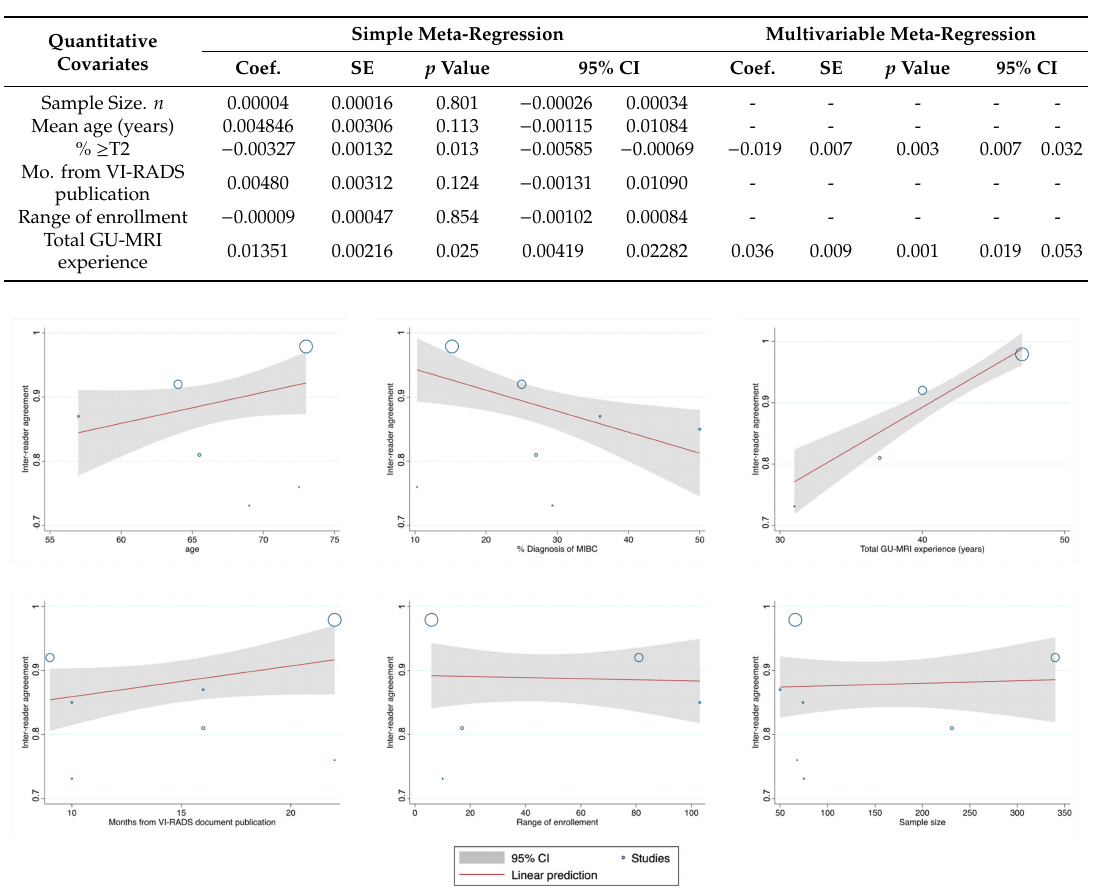
Table 4. Meta-regression analysis quantitative variables retrieved among the studies included in the analysis. SE; Standard Error; CI, Confidence Interval; GU, Genito-Urinary.